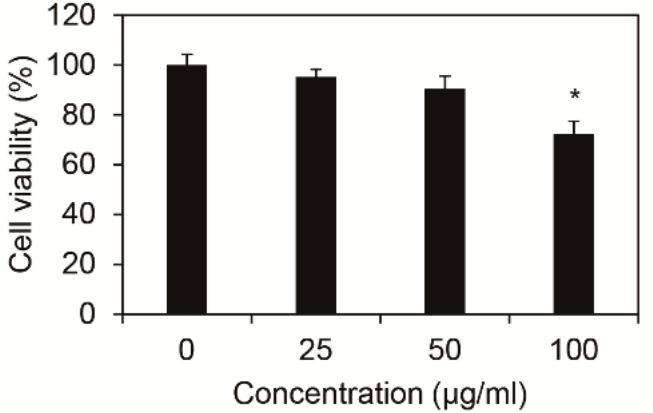
Figure 1. Cytotoxicity of extracts of Inonotus obliquus in human dermal fibroblasts. E ff ects of Inonotus obliquus extracts on the cell viability were expressed as a percentage of control at the indicated concentrations. Values are mean ± standard deviation (S.D.) from triplicate experiments. * p < 0.05 compared with non-treated cells.